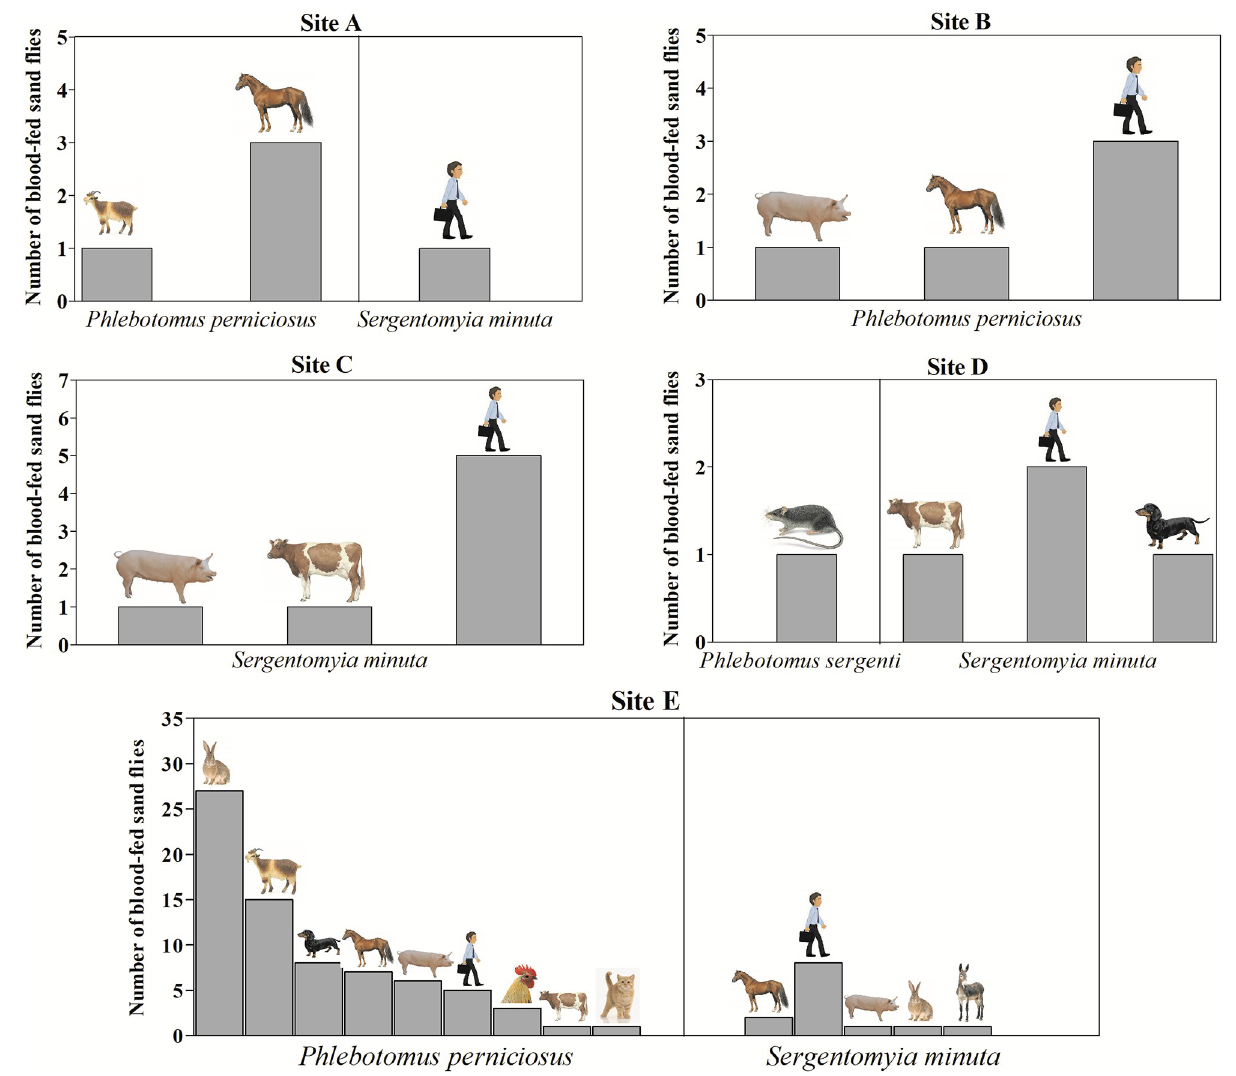
Fig 4. Vertebrate hosts identified per each sand fly species in selected sampling sites (A-E).